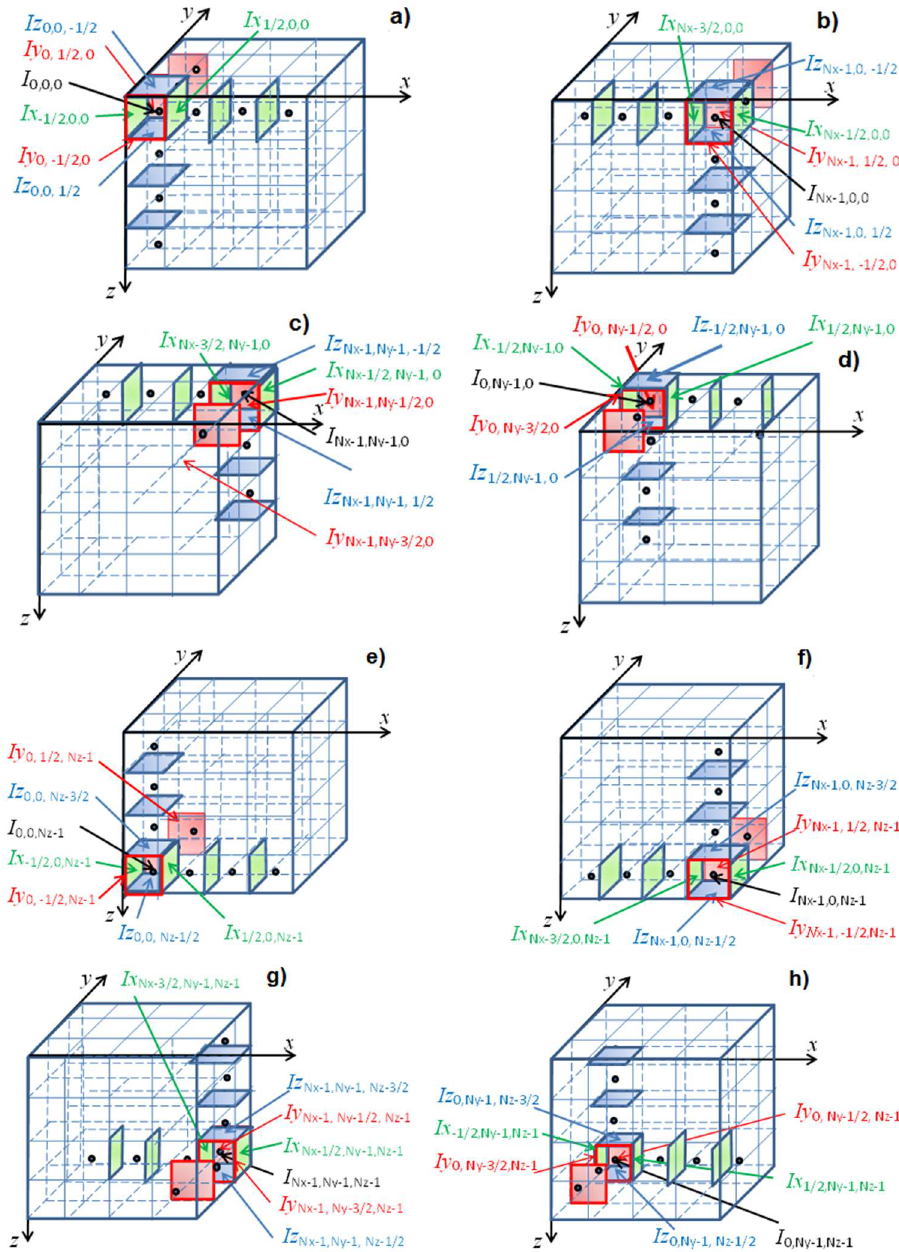
Figure 4. Location and sequence of the calculated elements of the grid: ( a ) I octant, ( b ) II octant, ( c ) III octant, ( d ) IV octant, ( e ) V octant, ( f ) VI octant, ( g ) VII octant, and ( h )VIII octant.